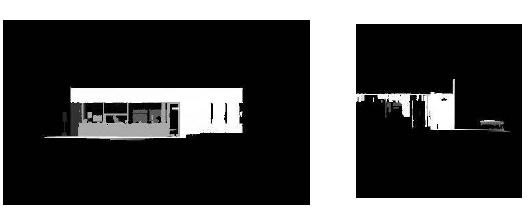
Figure 8. Plane Projection Image of viewpoint #1 Left: When the plane of interest is P a , Right: P c